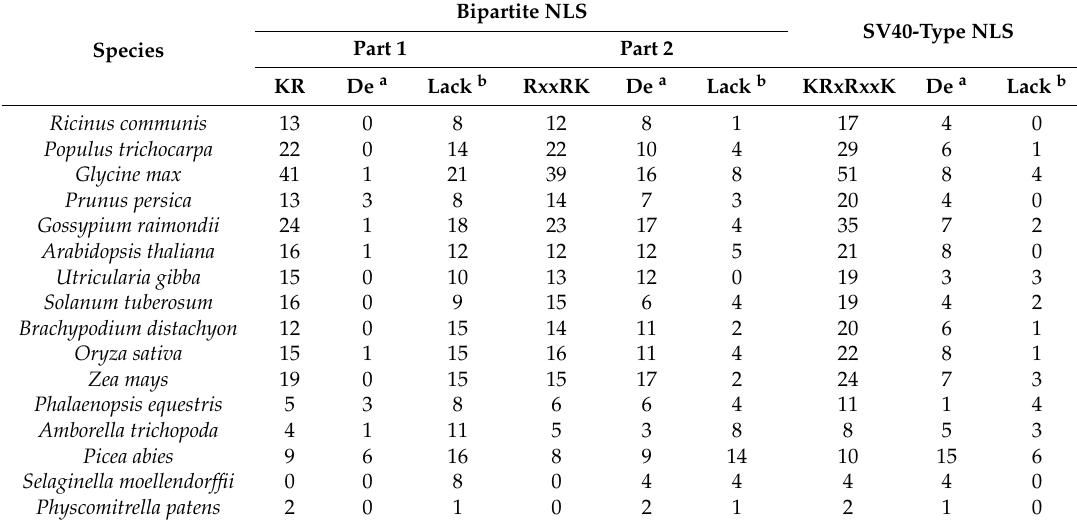
Table 3. The amino acid compositions of Aux/IAA NLSs in